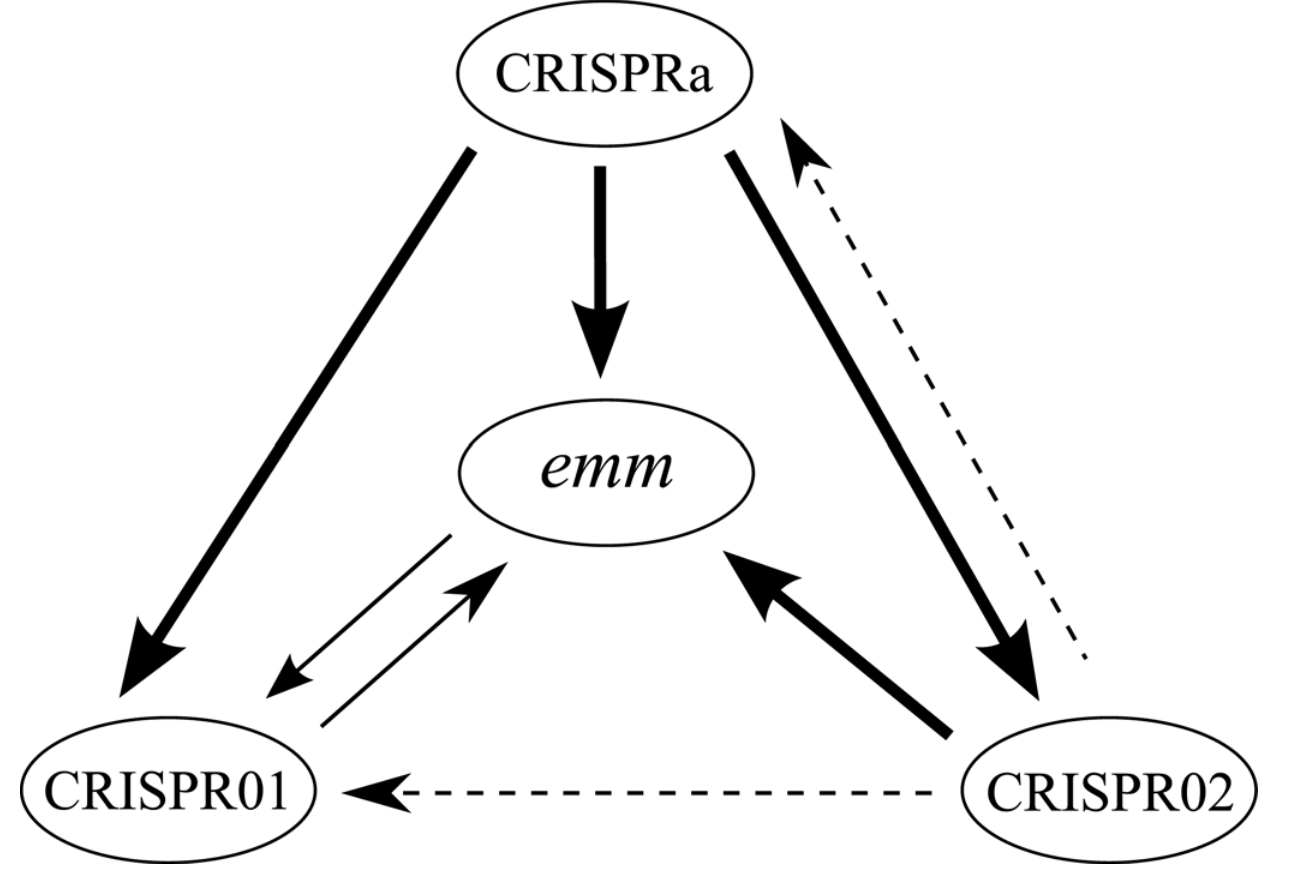
Fig 1. Correlations among emm , CRISPRa, CRISPR01, and CRISPR02 types. The congruence among different typing methods was estimated by Adjusted Wallace coefficients. The dash, thin, and thick arrows indicate Adjusted Wallace coefficients of 0.6~0.7, 0.7~0.9, and > 0.9, respectively.